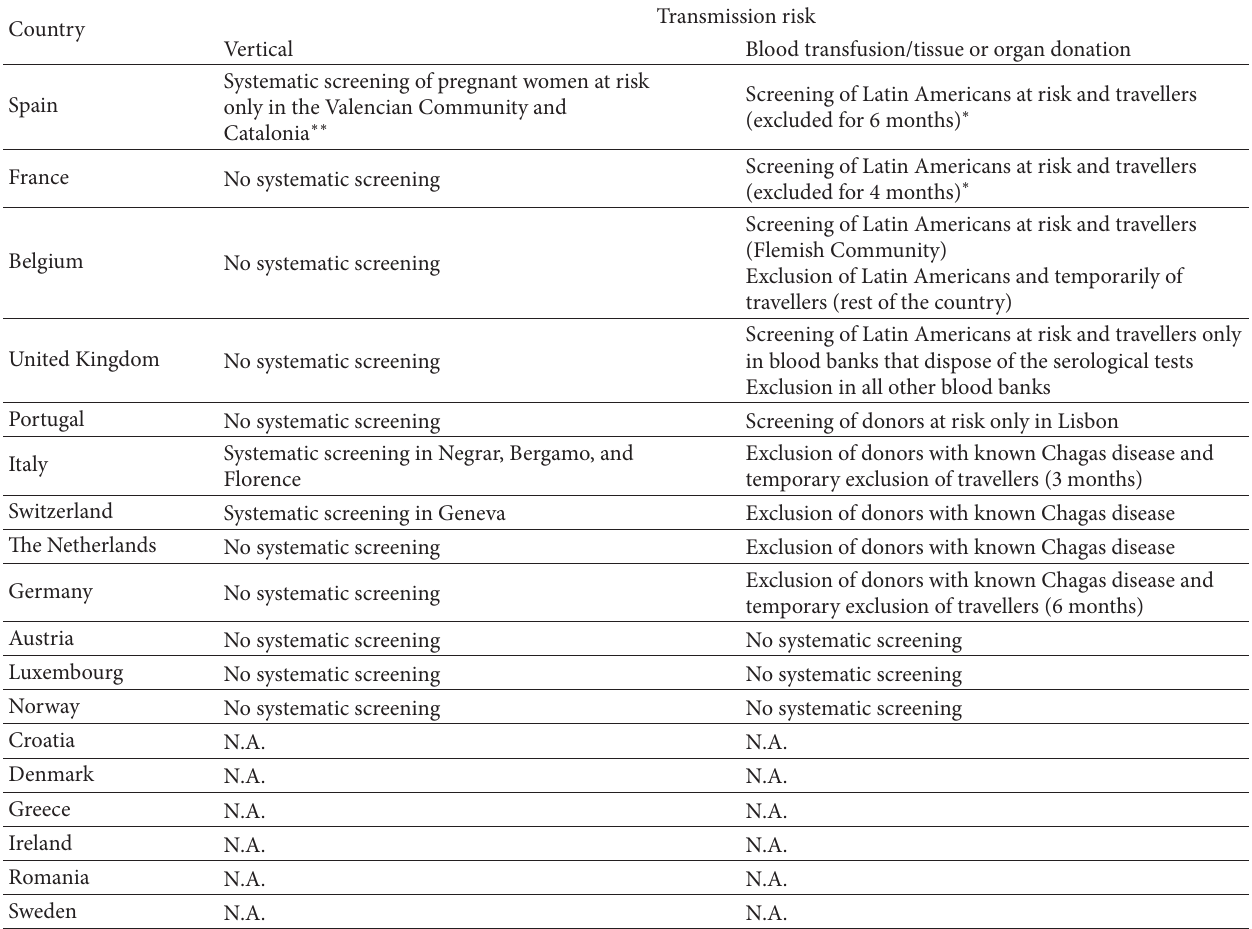
Table 2: Preventive measures and legislation of Chagas disease in Europe.